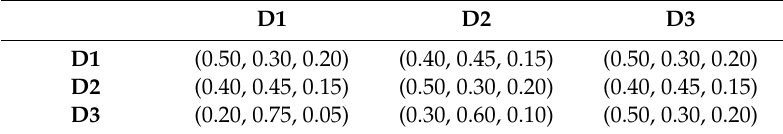
Table 8. Intuitionistic fuzzy preference relationship of green market trading